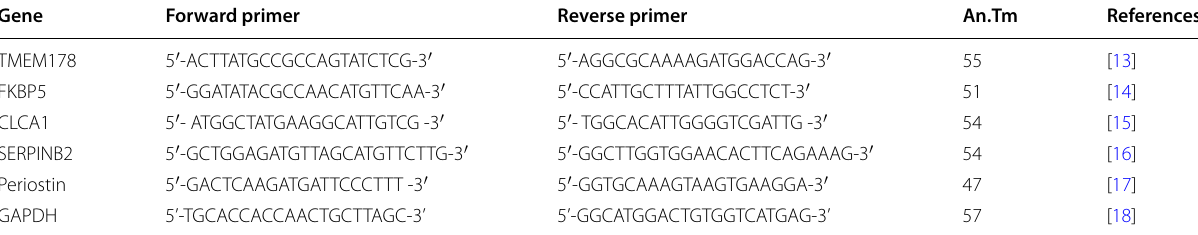
TMEM178: transmembrane protein 178, CLCA1: chloride pathway, calcium activated family member 1, SERPINB2: serpin peptidase inhibitor, clade B, member 2, GAPDH; glyceraldehyde 3-phosphate dehydrogenase